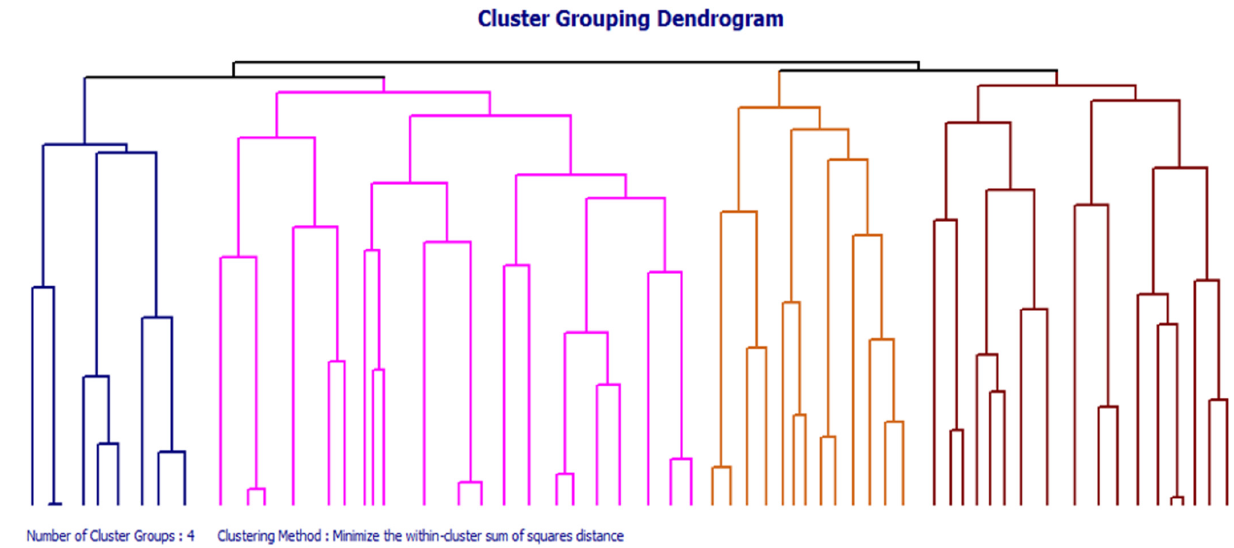
Figure 8. Cluster grouping dendrogram of the Zamzama Gas Field.